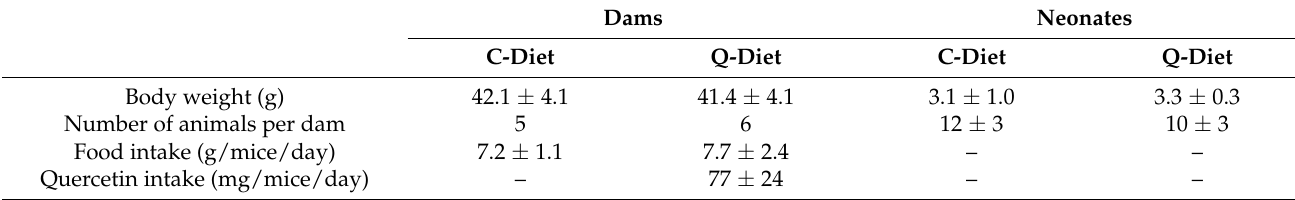
Table 2. Effects of quercetin consumption on food intake and body weight (first